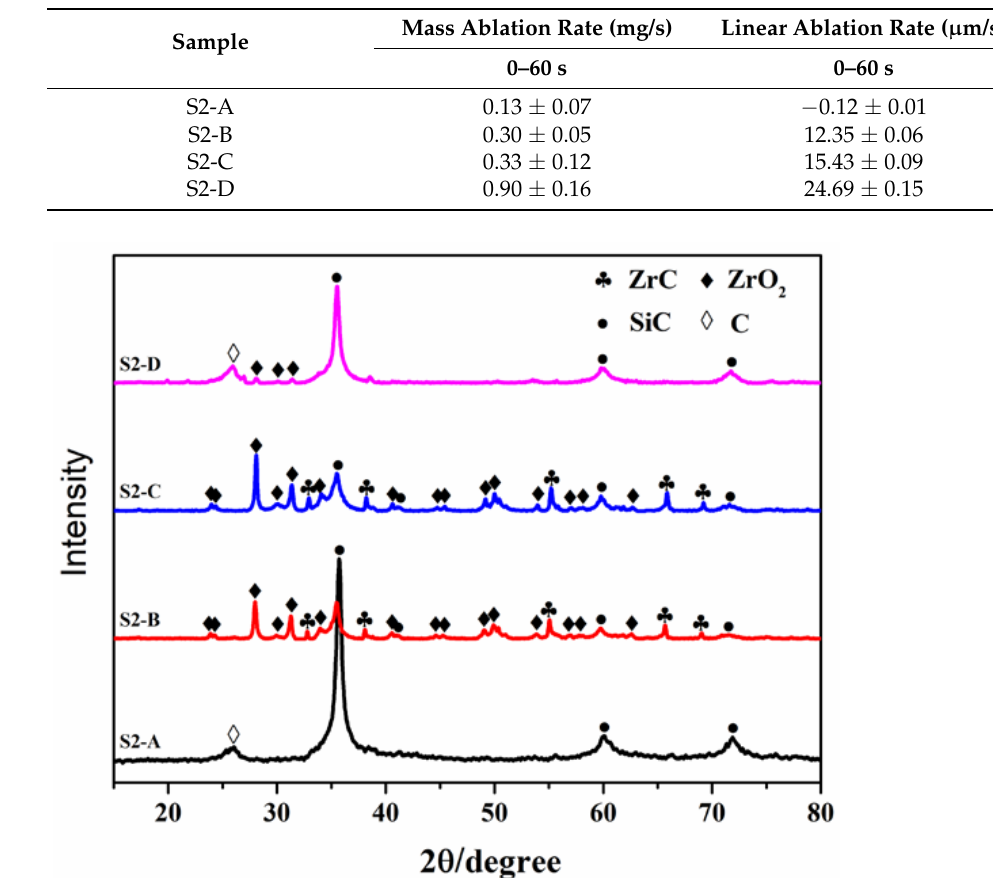
Table 3. The mass and linear ablation rate of S2 coatings after 60 s ablation.